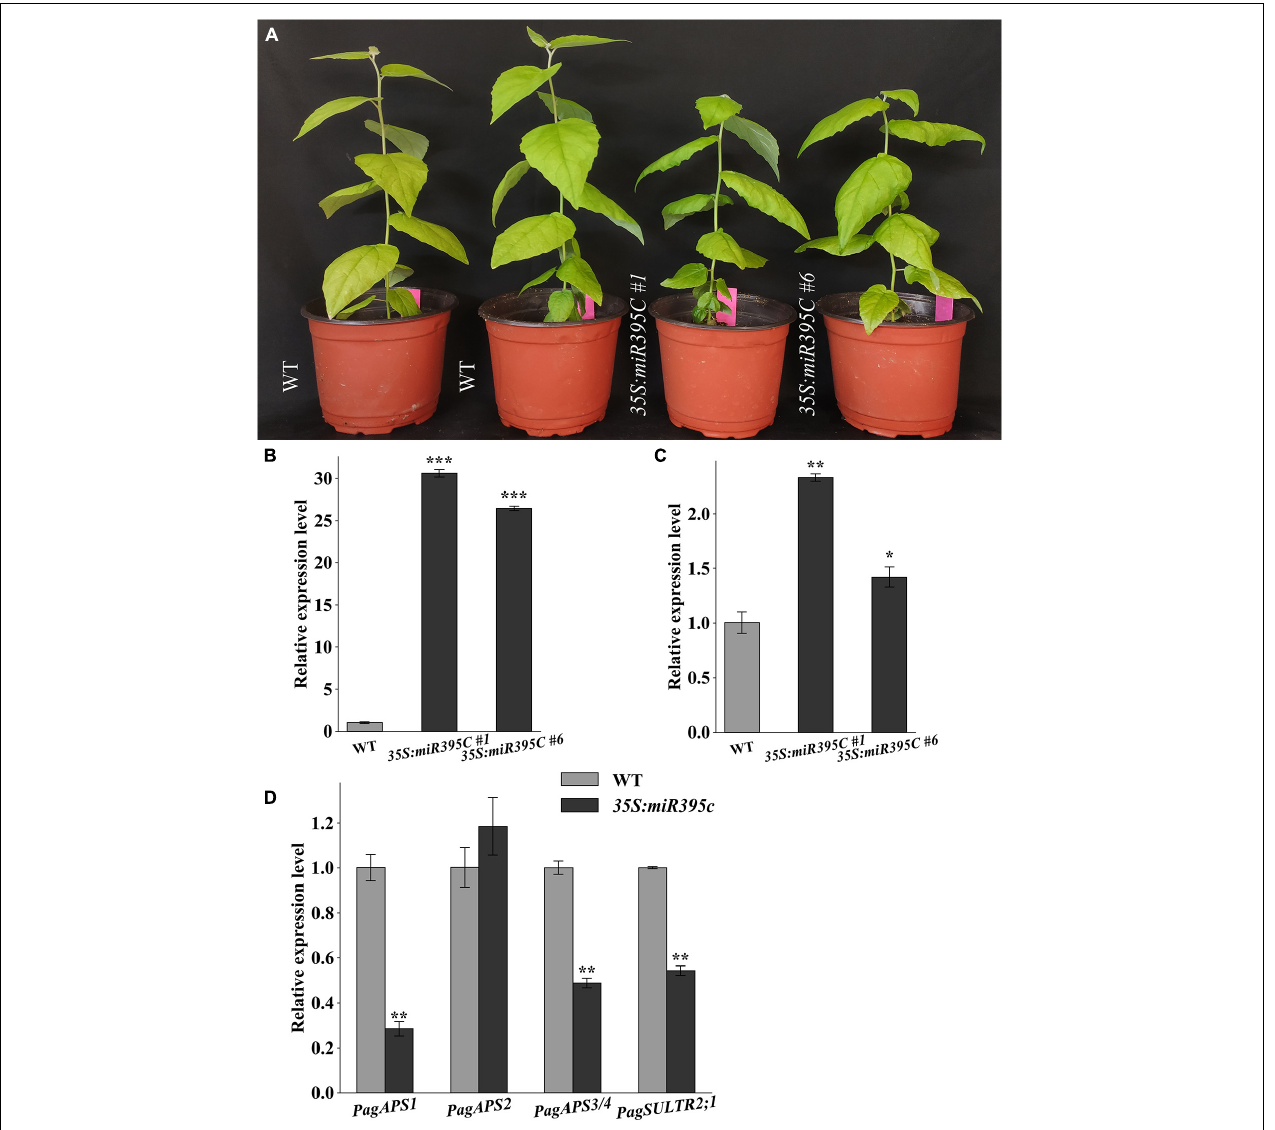
FIGURE 2 | Expression analysis of miR395c and its targets in miR395c-OE poplars. (A) The height of transgenic plants and wild type. (B) The expression of precursor miR395c increased in miR395c-OE poplars. (C) The expression of mature miR395c increased in miR395c-OE poplars. (D) The expression of PagAPS1 , PagAPS3/4, and PagSULTR2;1 decreased in the transgenic plants, while the expression of PagAPS2 changed slightly. Asterisks indicate significant difference between transgenic and WT plants using the Student’s t -test, * p < 0.05; ** p < 0.01; and *** p < 0.001.